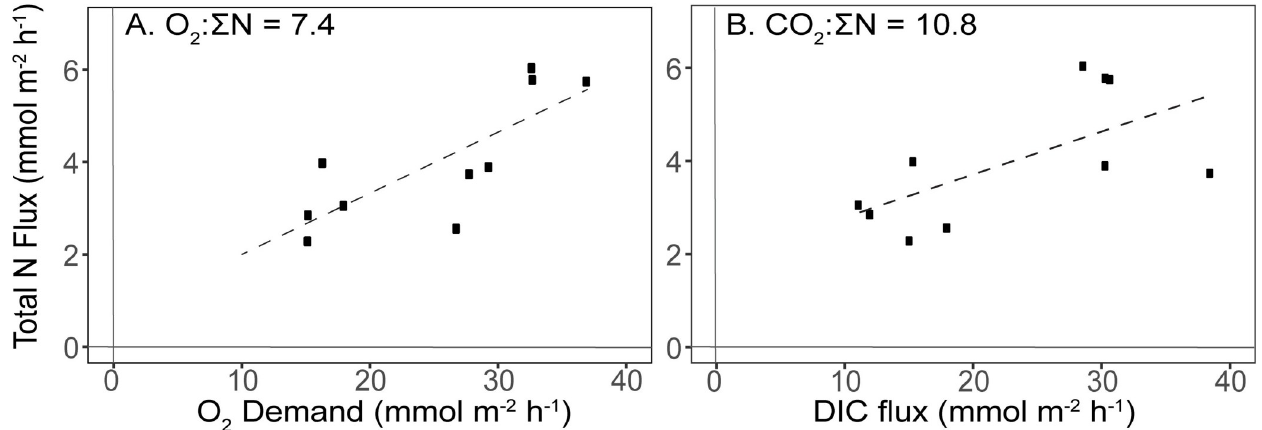
Fig 5. Stoichiometric plots using O 2 , DIC, and S N (sum of NH 4+ , NO 2/3- , and N 2 -N) from individual fluxes of oysters alone. We assume that CO 2 :O 2 is a 1:1 in the plot of (a) total N flux versus O 2 demand and get a CO 2 : S N ratio of 7.4. This is compared to an actual plot of (b) total N flux versus DIC flux, which had a CO 2 : S N ratio of 10.8. Both ratios are similar to the Redfield elemental ratio for marine algae (106:16).